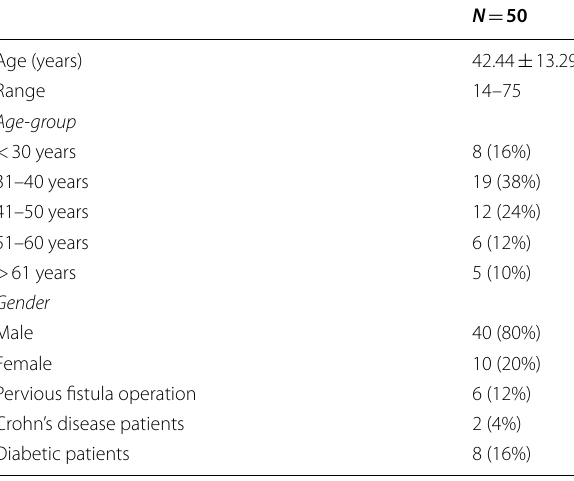
Table 5 Number and site of external opening among enrolled